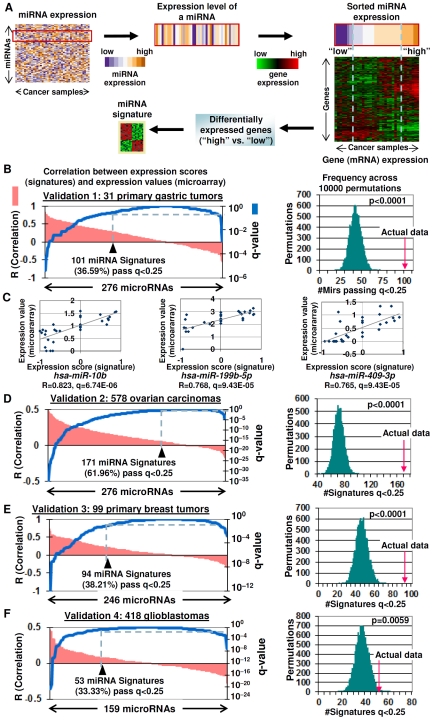
Gene expression signatures as surrogates of miRNA expression.A) Generating miRNA gene expression signatures. Differentially expressed genes are identified between samples expressing high and low miRNA levels (nominal p<0.0001). B) Validation of miRNA gene expression signatures (Validation Set #1:31 primary gastric tumors). (Left graph) Plot of Spearman correlations between miRNA gene expression scores and miRNA expression values (pink) and corresponding q-values (blue). The black triangle highlights the number of miRNA signatures passing the R>0, q<0.25 threshold. (Right graph) Distribution of miRNAs exhibiting positive correlations between miRNA gene expression scores and miRNA expression values (R>0 and q<0.25), after the miRNA labels were randomly shuffled across 10000 permutations. The red arrow represents the number of positively correlated miRNAs in the actual data. C) Examples of miRNAs in Validation set #1 showing high correlations between miRNA gene expression scores and miRNA expression values. All p-values were corrected for multiple hypotheses (shown as q-values). D-F) Validation of miRNA gene expression signatures in (D) Validation Set #2:578 ovarian carcinomas, (E) Validation Set #3:99 primary breast tumors, and (F) Validation Set #4:418 glioblastomas. For Validation Sets #3 and #4, the numbers of miRNAs analyzed were limited to miRNAs present in both the gastric-derived 276 miRNA signatures and miRNA expression data in the validation set.